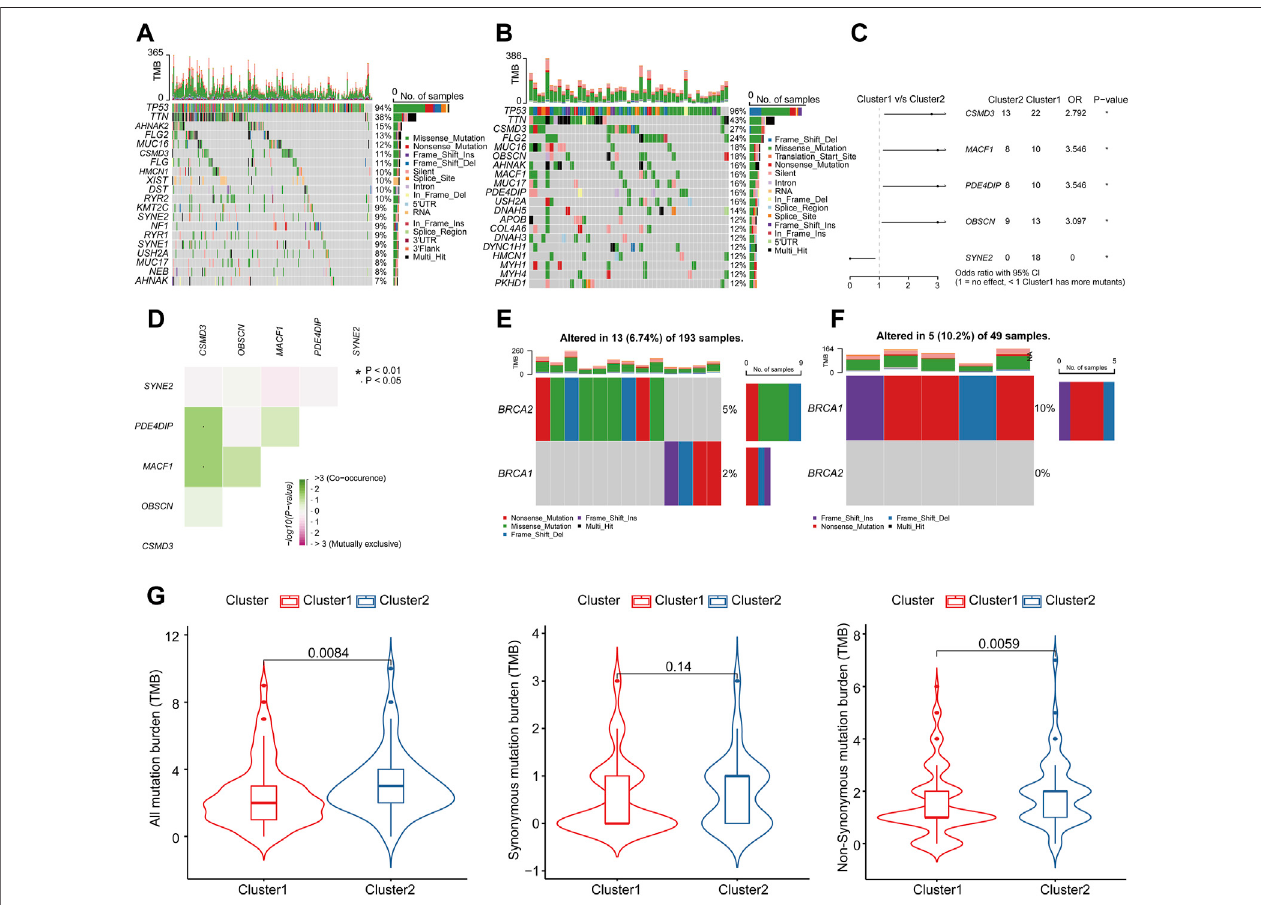
FIGURE 5 | The landscape of mutation pro fi ling in different subtypes of OC. The waterfall plot showed the mutation information of each gene in each sample of (A) Cluster 1 and (B) Cluster 2. The top panel exhibited the number of variants and the bottom panel showed various mutation types. (C) The forest plot described the subgroup analysis of signi fi cantly mutated genes. * p < 0.05, and ** p < 0.01 determined by one-sided z test and two-sided chi-squared test. (D) Mutually co-occurring and exclusive associations across mutated genes in OC were displayed as a triangular matrix. Green and pink indicated a tendency toward co-occurrence and exclusiveness,respectively.ThewaterfallplotshowedthemutationinformationofBRCA1/2ineachsampleof (E) Cluster1and (F) Cluster2. (G) Theviolinplotsshowed the TMB differences in different subtypes of